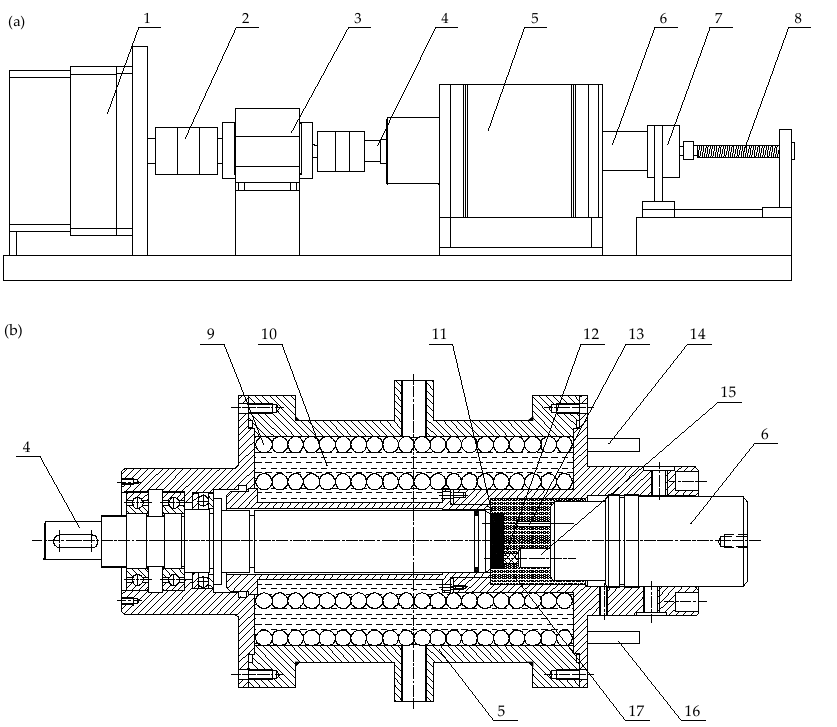
Figure 4. ( a ) The testing machine system and the physical map; ( b ) schematic diagram of the internal structure of the low-temperature cavity.1—converter motor; 2—couplings; 3—torque sensor; 4—rotation axle; 5—low-temperature cavity; 6—axle; 7—loading sensor; 8—loading screw; 9—copper tube; 10—coolant; 11—the disc sample; 12—the pin sample; 13—temperature sensors; 14—outlet of coolant; 15—the fixture of pin; 16—inlet of coolant; 17—the tested hydraulic oil.